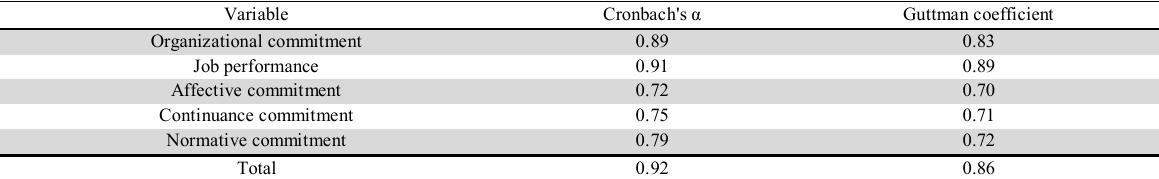
The reliability of measuring